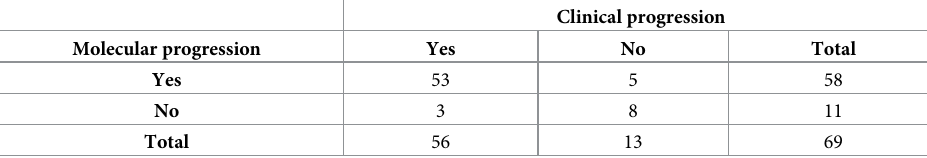
Table 2. Progression comparison for patients who were both clinical and molecular